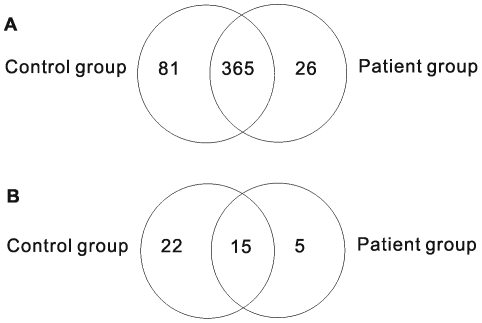
Venn diagram of the known miRNAs and novel miRNA*(star)s of the known miRNAs identified from the control group and the ALL patient group.(A) Known miRNAs unique in each group and shared by both. (B) MiRNA*s of known miRNAs unique in each group and shared by both.